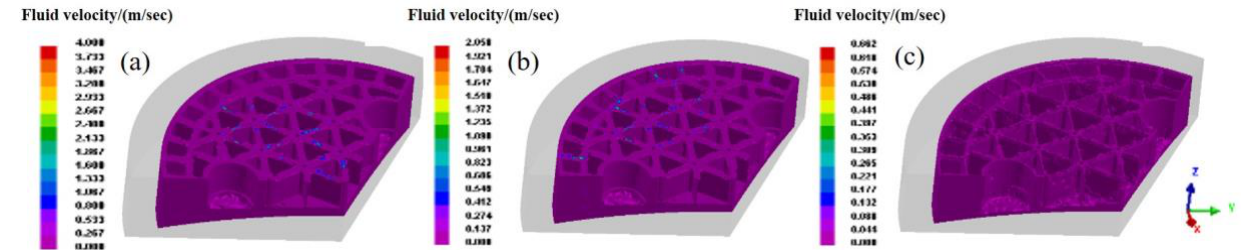
Figure 12 Figure 12. Fluid velocity for gating system with exhaust hole after gel-casting process. ( a ) 20 mm/s; ( b ) 10 mm/s; ( c ) 5 mm/s.